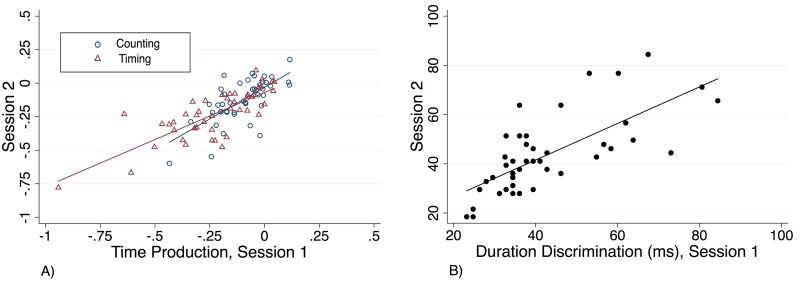
Repeat testing sessions.Performance during session one and session two for a) both counting (Pearson’s r = 0.70; p < 0.001) and timing (r = 0.78; p < 0.001) conditions of the time production task, as well as the b) duration discrimination (r = 0.71; p < 0.001) task.